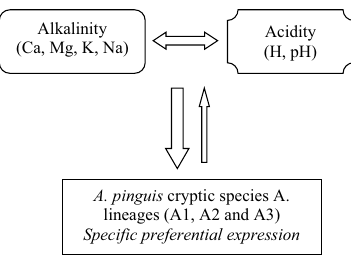
Figure 7. Aneura pinguis conceptual site-specific preferential expression towards alkalinity and acidity